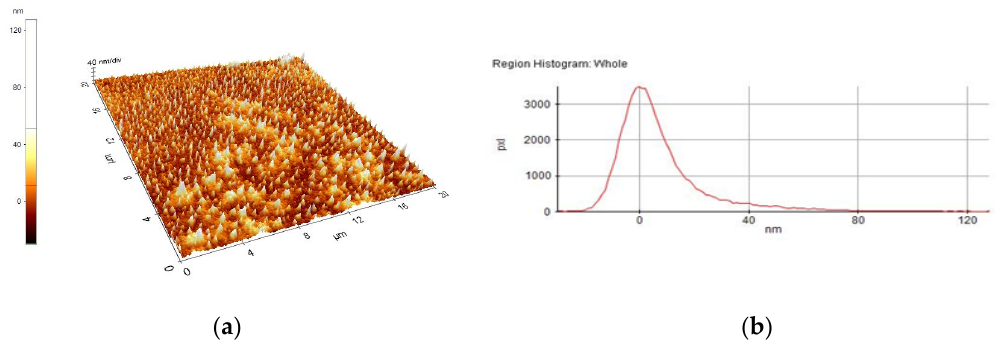
Figure 4. AFM image of 1%rGO-SiO 2 -P 2 O 5 /glass film: ( a ) morphology, ( b ) region histogram.